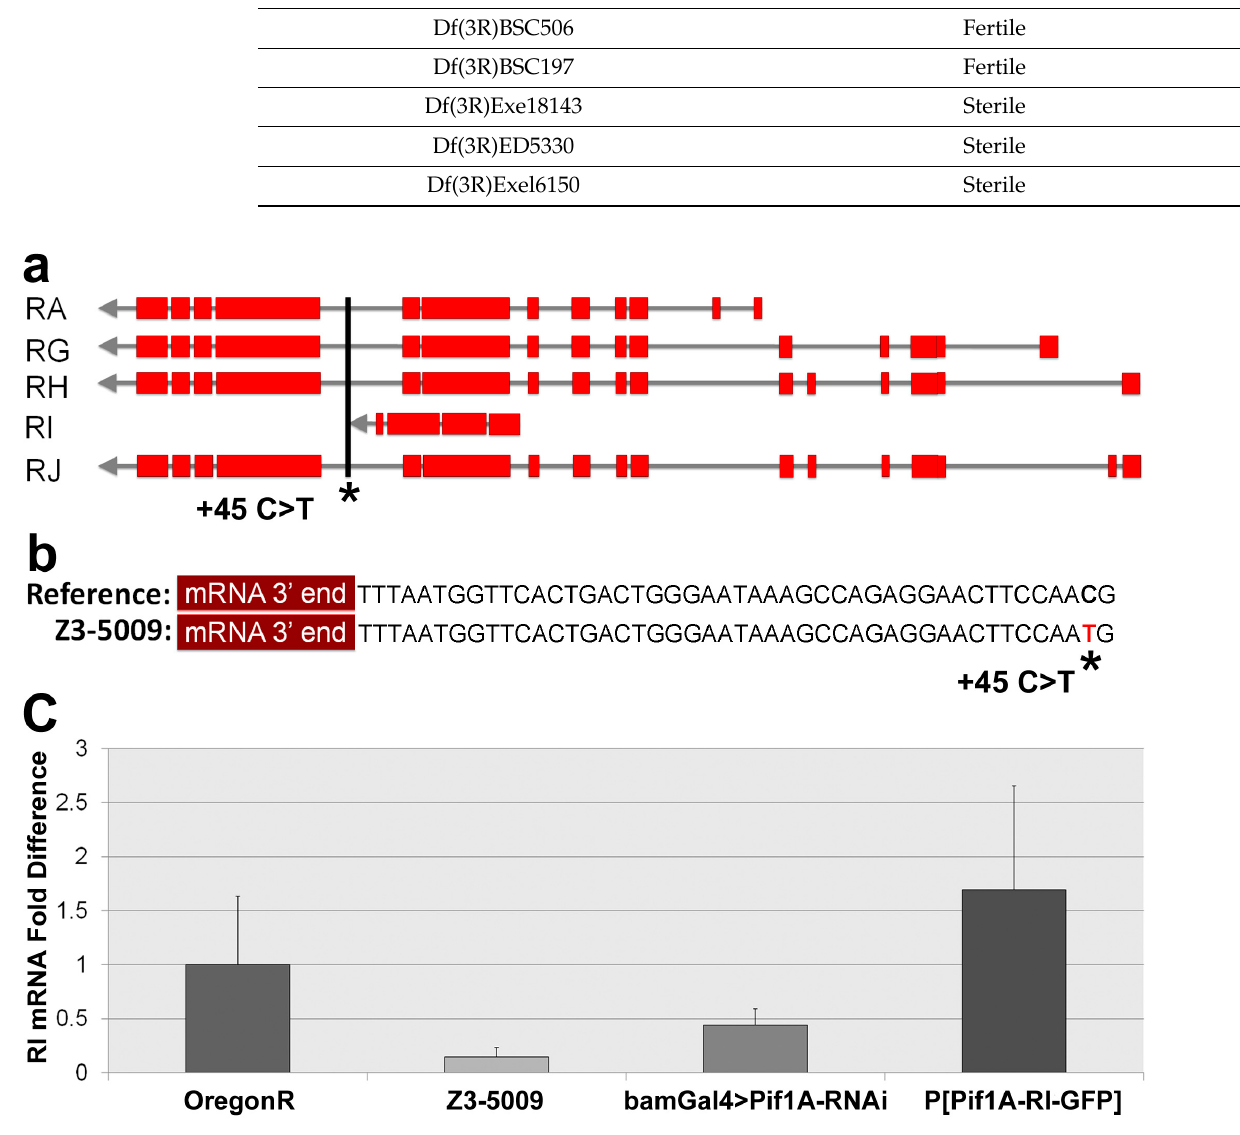
Figure 8. Pif1A overview and qPCR. Transcript map of the five predicted Pif1A transcripts ( a ). Exons of each transcript are shown in red; Pif1A-RI is the transcript used for rescue and targeting in RNAi. The SNP thought to be responsible for the phenotype is 45 bp downstream from the last codon of the Pif1A-RI mRNA transcript ( b ); it is a C>T transition. Relative Pif1A-RI mRNA expression levels in male testes ( c ); expression is decreased in Z3-5009 mutant. Error bars represent ± standard error. Table 1. Male fertility status of selected Drosophila deficiency lines.